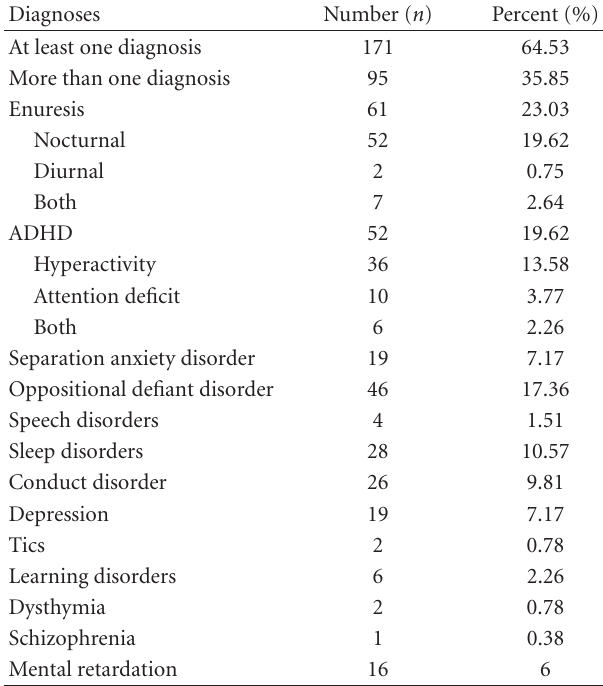
Table 2: Descriptive statistics for the child behavioral checklist.